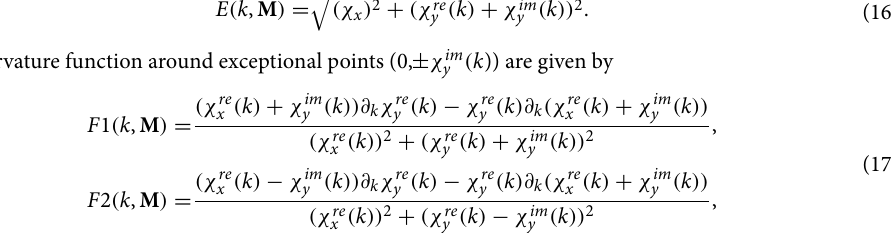
The curvature function around exceptional points (0,